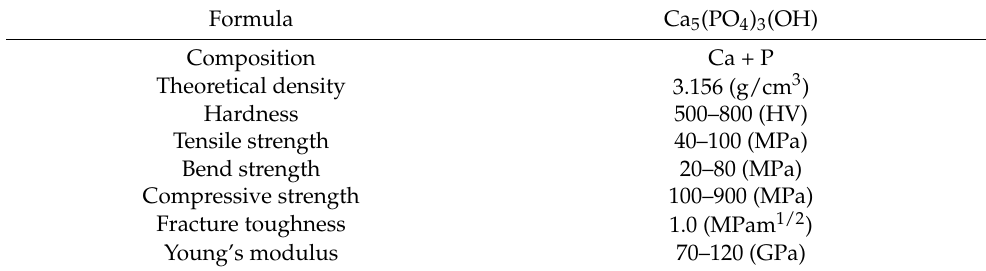
Table 2. Properties of hydroxyapatite [73].